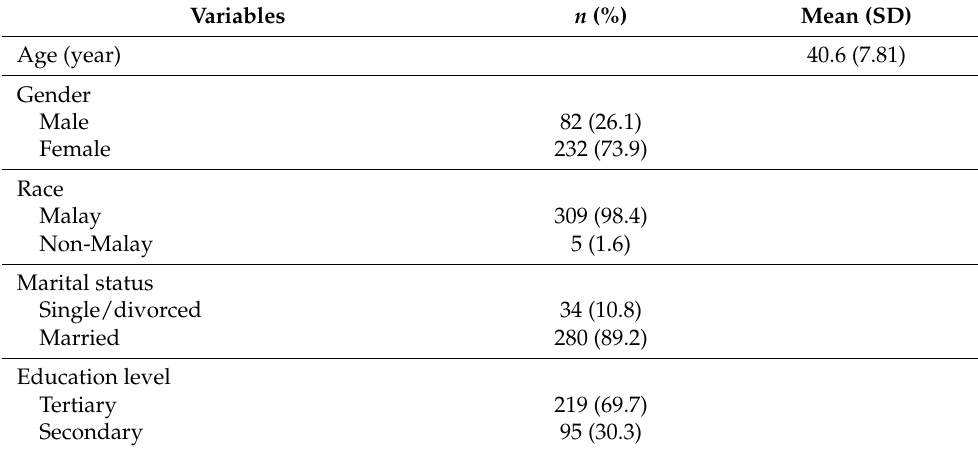
Table 2. Sociodemographic characteristics of the healthcare workers in ‘Type 2 Health Clinics’ in north-eastern Malaysia ( n =